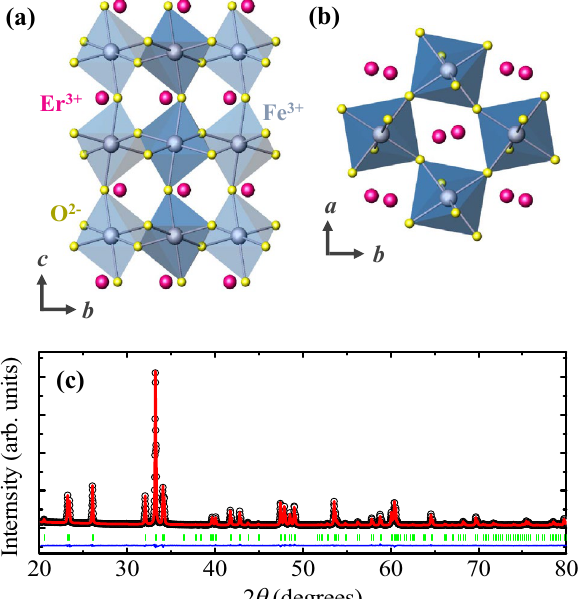
Figure 1. Crystallographic structure of ErFeO 3 . ( a ) and ( b ) Schematics of the crystallographic structure of perovskite ErFeO 3 (EFO) from the a and c axes, respectively. The pink, grey, and yellow spheres represent Er 3+ , Fe 2+ , and O 2− ions, respectively. ( c ) Observed (open circles) and calculated (solid line) powder X-ray diffraction patterns for the ground EFO single crystals. The blue curve represents the intensity difference between the observed and calculated patterns. The green short lines denote the Bragg